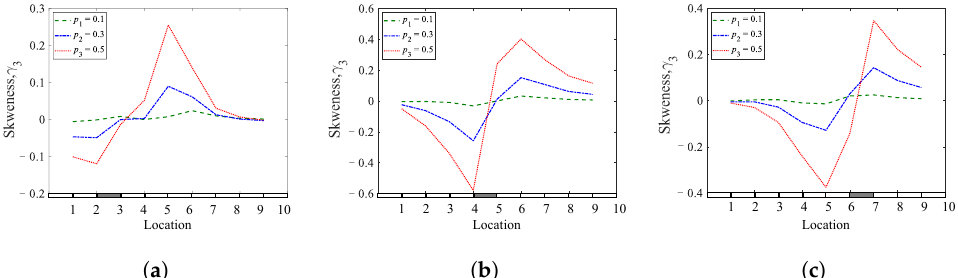
Figure 16. Skewness coefficients of a fixed-fixed beam for different crack depths and locations: ( a ) q 1 = 0.25; ( b ) q 2 = 0.45; ( c ) q 3 =